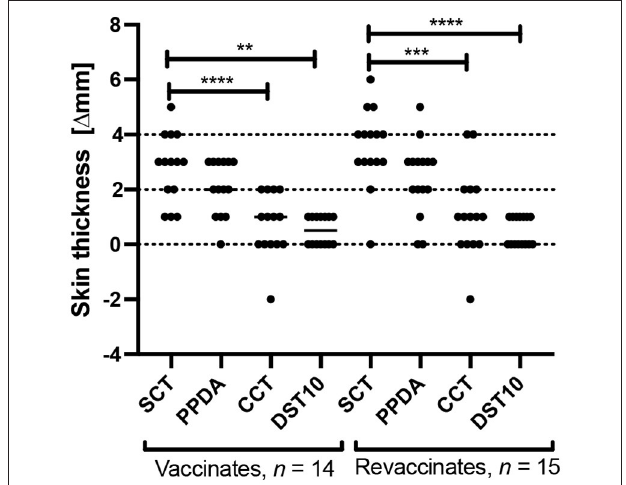
FIGURE 3 | Skin test responses induced by PPD-B (SCT), PPD-A, CCT, and DST10 (10 µ g per peptide constituent) were measured 72h post injection in calves vaccinated with BCG for the first time ( n = 14) and in revaccinates ( n = 15). Results are expressed as the difference in skin thickness (in millimeters) between pre- and post-skin test readings, with the horizontal line providing the median [ ± 95% confidence interval (CI)]. The statistical difference between the responses was determined using Tukey’s multiple comparison test (**** p < 0.0001, *** p < 0.001, ** p < 0.01). The dotted horizontal lines at 2 and 4mm are the cutoffs used for DST, and SCT and CCT,